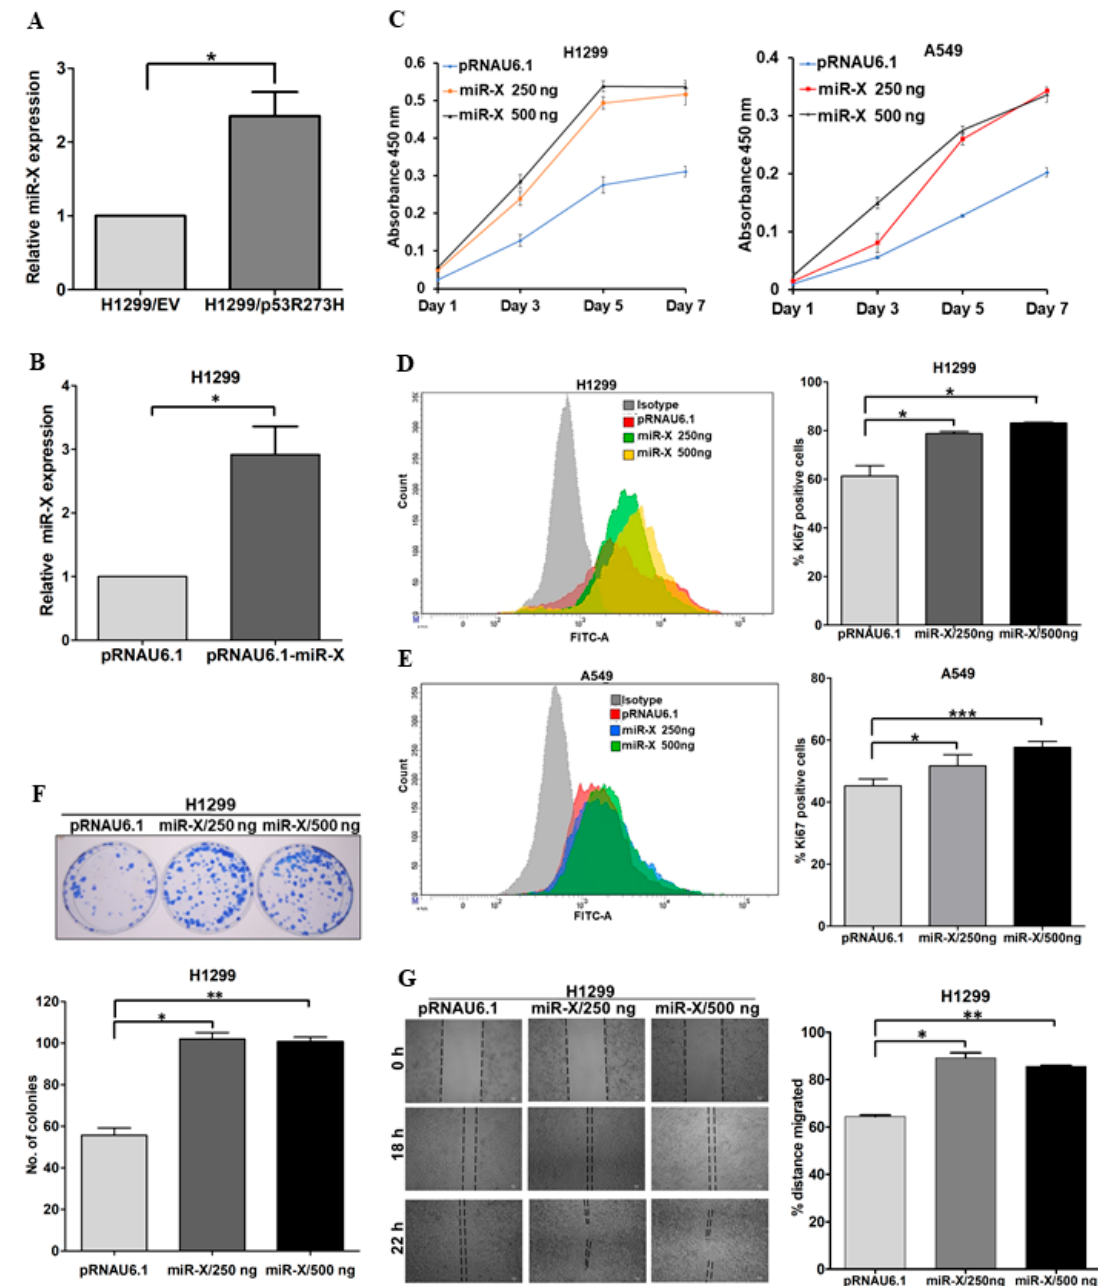
Figure 9. miR-X promotes oncogenic properties in lung cancer cells . (A) QRT-PCR data showing relative expression levels of miR-X in H1299/EV and H1299/mutant p53 R273H stable cell lines (B) QRT-PCR data showing ectopic expression of miR-X in H1299 cells transfected with pRNAU6.1-miR-X. H1299 cells were transfected with either empty pRNAU6.1 vector or with 250 ng of pRNAU6.1-miR-X. Forty eight hours post-transfection relative miR-X expression was evaluated using qRT-PCR. (C) Bar graphs showing relative proliferation of H1299 (left panel) and A549 (right panel) cells upon ectopic expression of miR-X as measured by WST-1 cell proliferation assay. Cells were transfected with either empty vector or miR-X expression plasmid and 16 hours post-transfection WST-1 assay was performed for the day 1 and for the days indicated. Data represents average absorbance values at 450 nm of three independent experiments. (D and E) (Left panels) Histogram showing mean fluorescent intensities of empty vector and miR-X transfected H1299 (D) and A549 (E) cells stained with anti-Ki-67 antibody as measured by FACS analyses. (Right panels) Bar graphs showing relative percentages of Ki-67 positive H1299 (D) and A549 (E) cells transfected with control empty vector or with miR-X expression plasmid. (F) (Upper panel) Representative images of colonies formed by